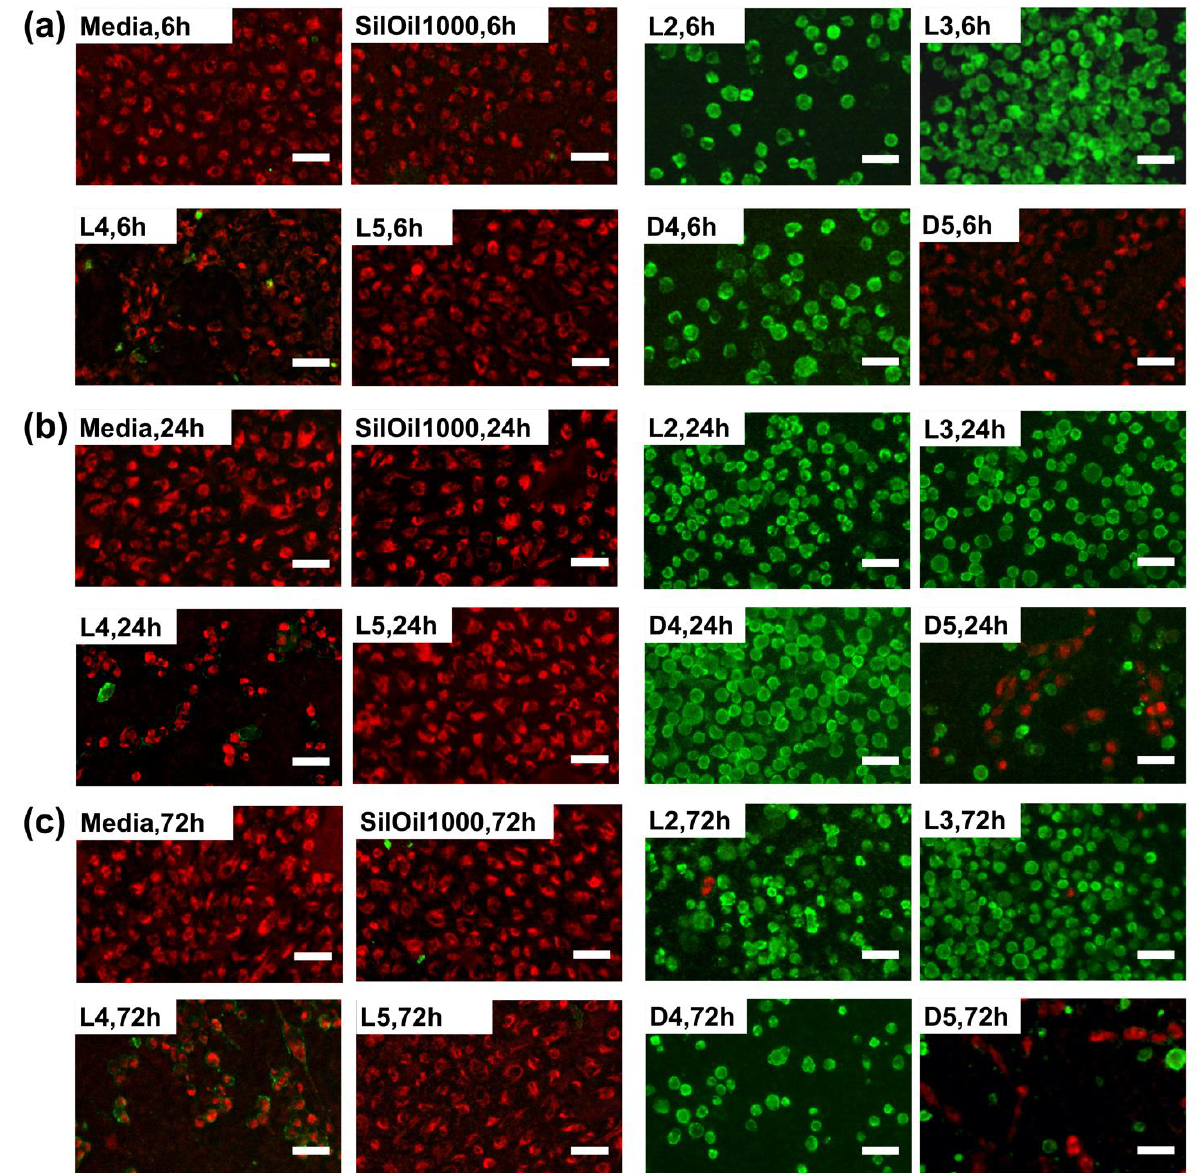
Figure 6. Fluorescent microscopic images of the ARPE-19 cells after incubating with liquid LMWCs and control groups at ( a ) 6 h, ( b ) 24 h and ( c ) 72 h. Cells in red and green represent living and dead cells, respectively. The results in ( a – c ) are representative of those from 1 independent experiment with 2 replicates each.